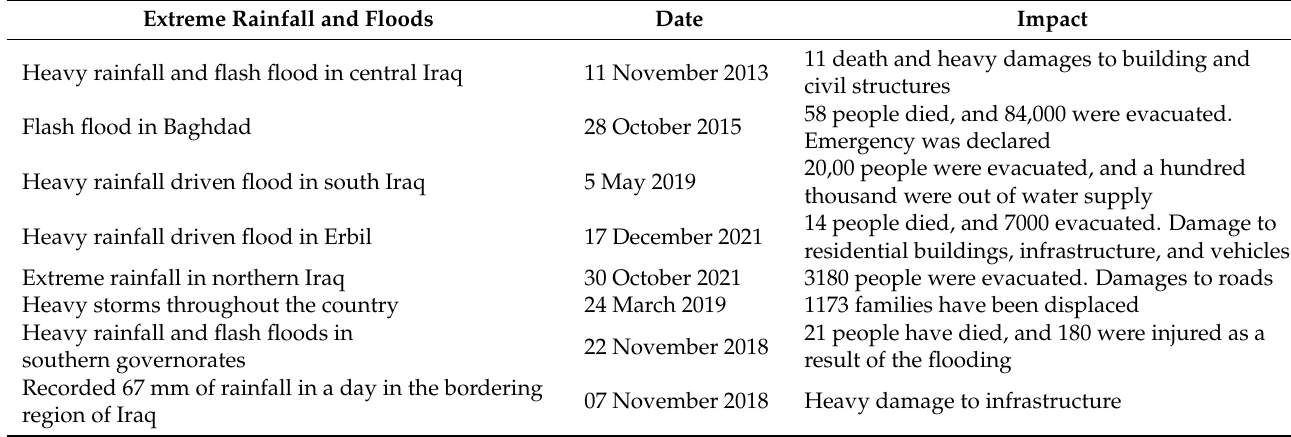
Figure 2. Annual mean rainfall in